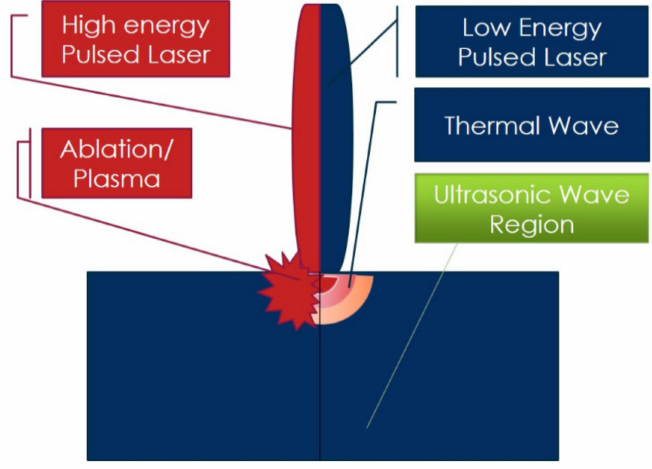
Figure 1. Effects of different energies of the excitation laser on the target material causing thermal expansion or